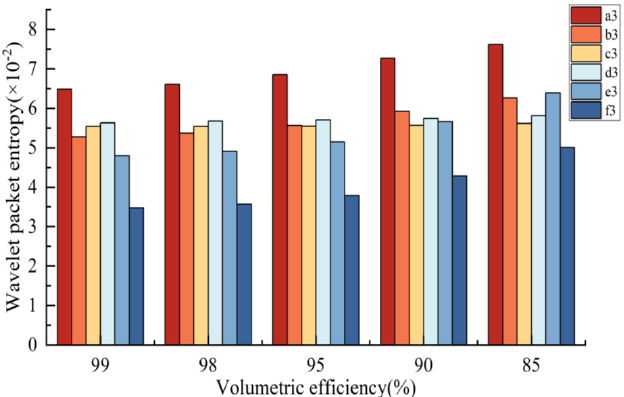
Figure 21. Fault feature of leakage in hydraulic motor.